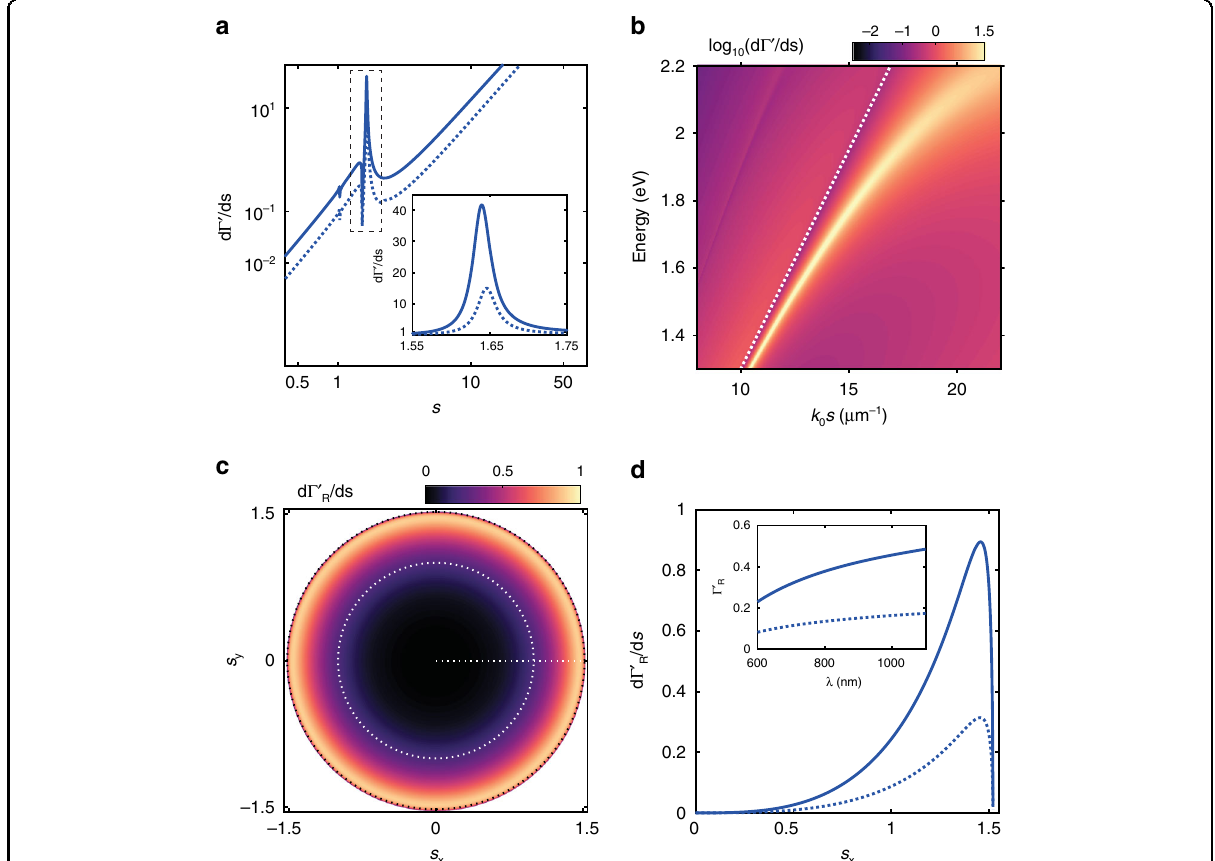
Fig. 2 Radiative and non-radiative decay rates for the Au//hBN//Gr TJ. a Power dissipation spectrum for the anisotropic ( d Γ ’ / ds , solid-line) and the isotropic ( d Γ / ds , dotted-line) case evaluated at 750 nm for the Au//hBN//Gr TJ. The peaks at s ∼ 1.58 (inside the dashed-line box) represent SPP glass mode. Inset shows the plot in linear scale, demonstrating the enhancement in d Γ '/ ds ( ∼ ×4) as compared to d Γ / ds . b d Γ ’ / d s plotted as a function of k 0 s and (cid:1) h ω (in log10 scale), representing the dispersion of the Au//hBN//Gr TJ. The bright band represents the dispersion of the SPP glass mode and = ds evaluated at λ = 750 nm as a function of ( s the dotted line shows the light dispersion in the glass. c Radiative decay rate spectrum d Γ ′ (cid:4) (cid:5) x , s y ). Light- R þ s 2 ¼ 1 þ s 2 ¼ n Þ media are shown as inner and outer dashed circles respectively. d d Γ ′ and glass ð s 2 / ds (solid-line) obtained lines in air s 2 glass R x y x y = ds along the dashed-horizontal line in ( c ) and the corresponding d Γ R / ds (dotted-line) for the isotropic case, demonstrating the enhancement in d Γ ′ R , solid-line) and the isotropic ( Γ R , dotted-line) case ( ∼ ×3) as compared to d Γ R / ds . Inset shows the total radiative decay rate for the anisotropic ( Γ ′ R evaluated in the wavelength range of 600-1100